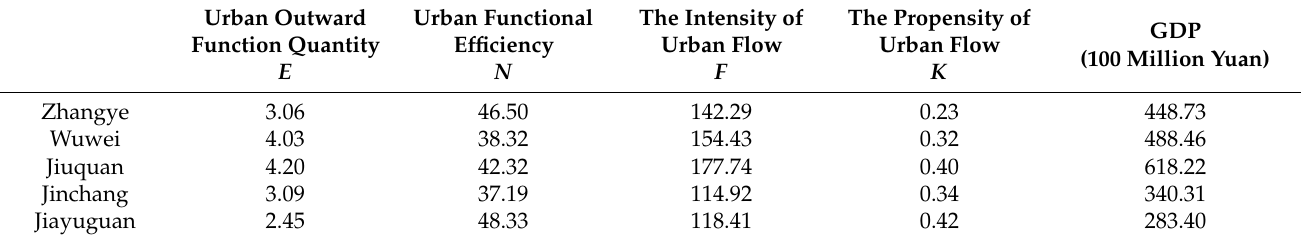
Table 4. Cities’ total outward energy and the degree and intensity of urban